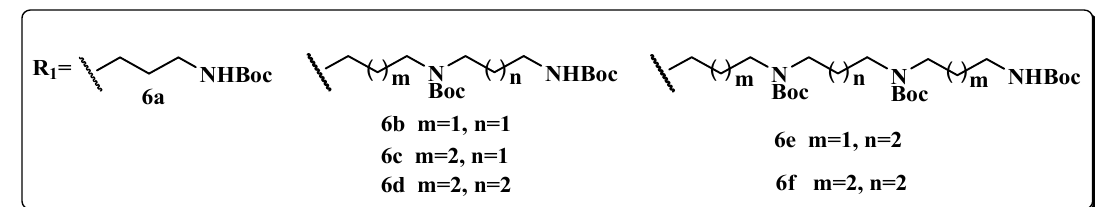
Figure 2. Building blocks of the polyamine skeleton.